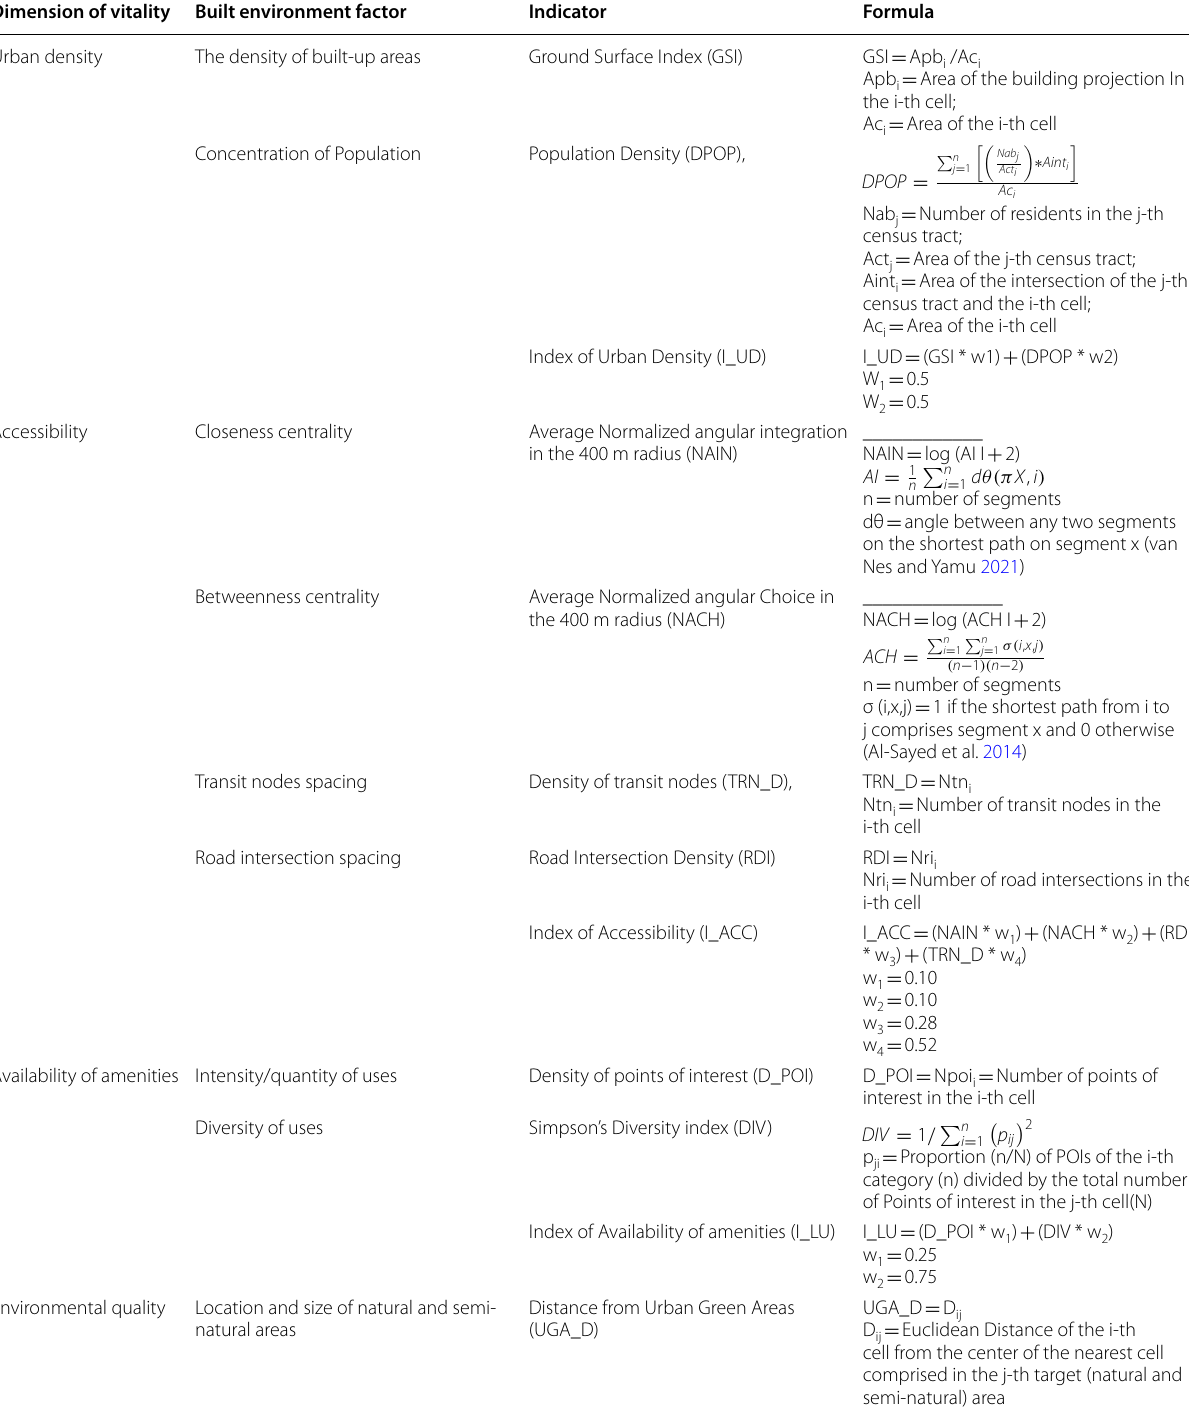
Table 1 Factors of the built environment, Individual indicators, dimensional Indicators and Synthetic Index of the latent vitality of